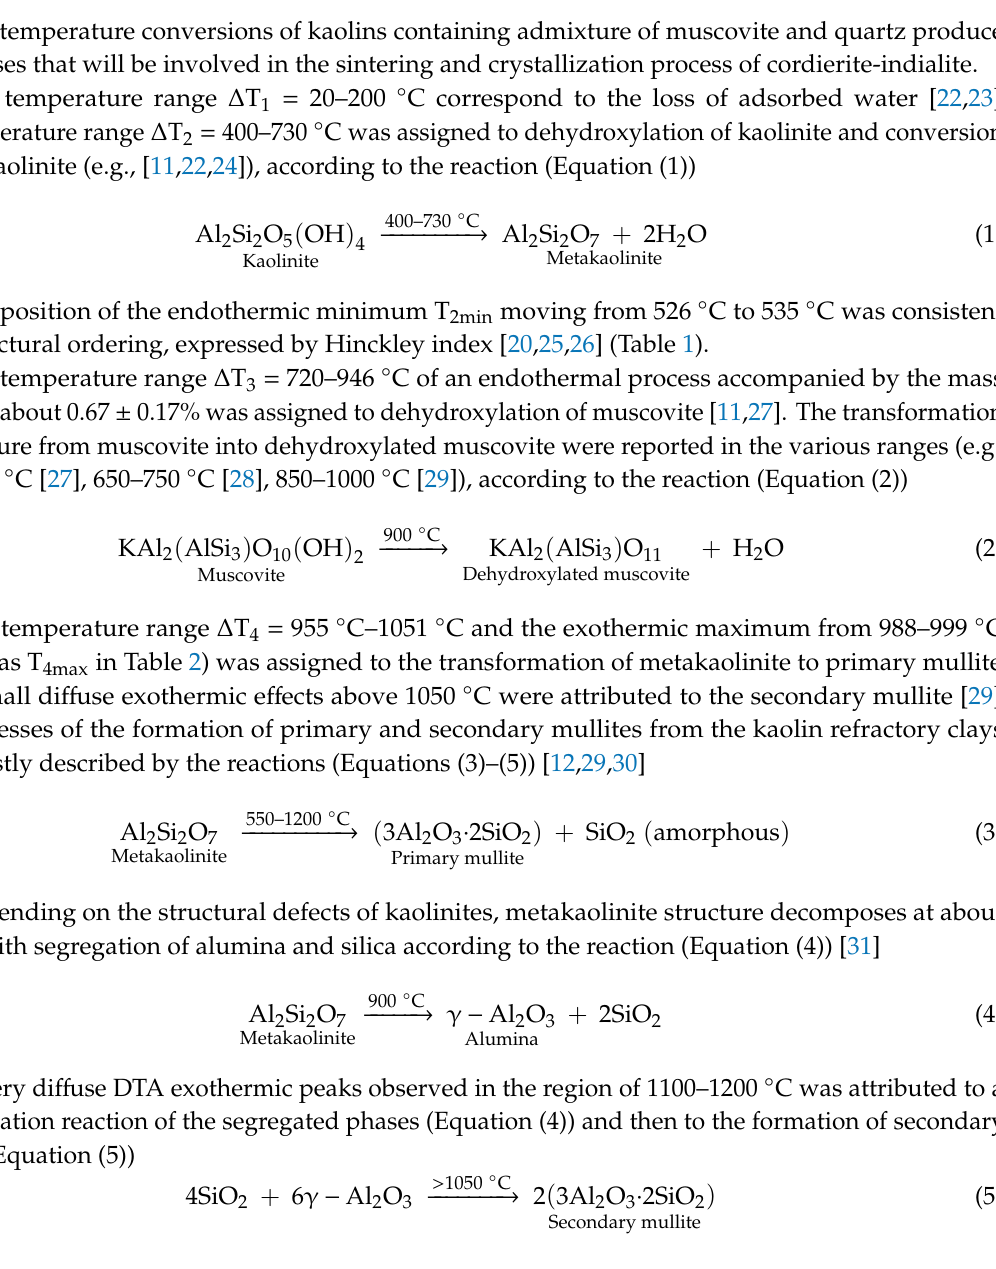
Figure 2. DTA curves of kaolin